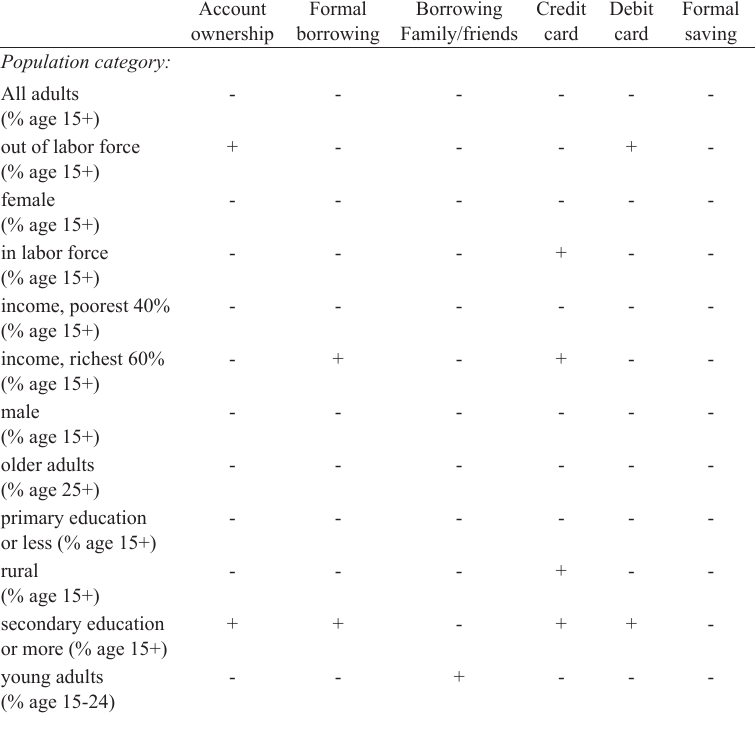
Population Summary Matrix for Growth in